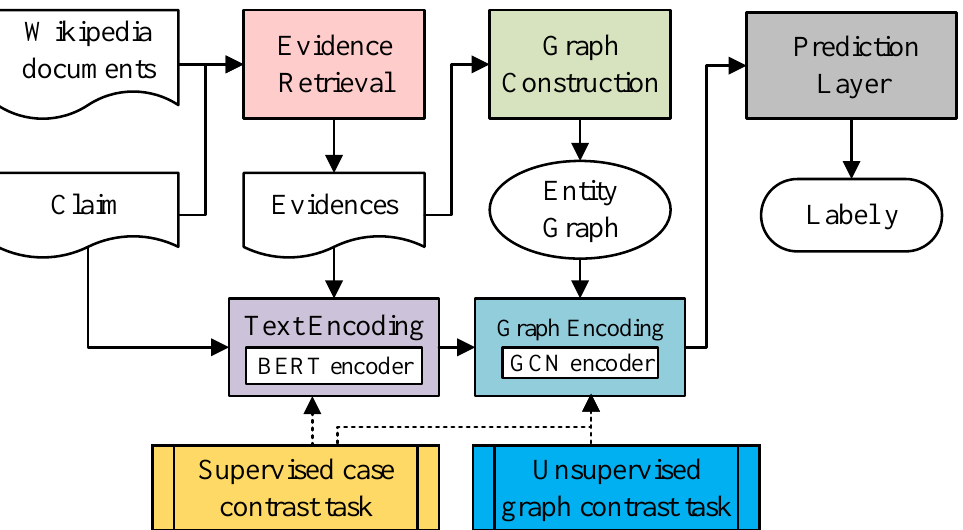
Figure 2. Overview of the CosG model.